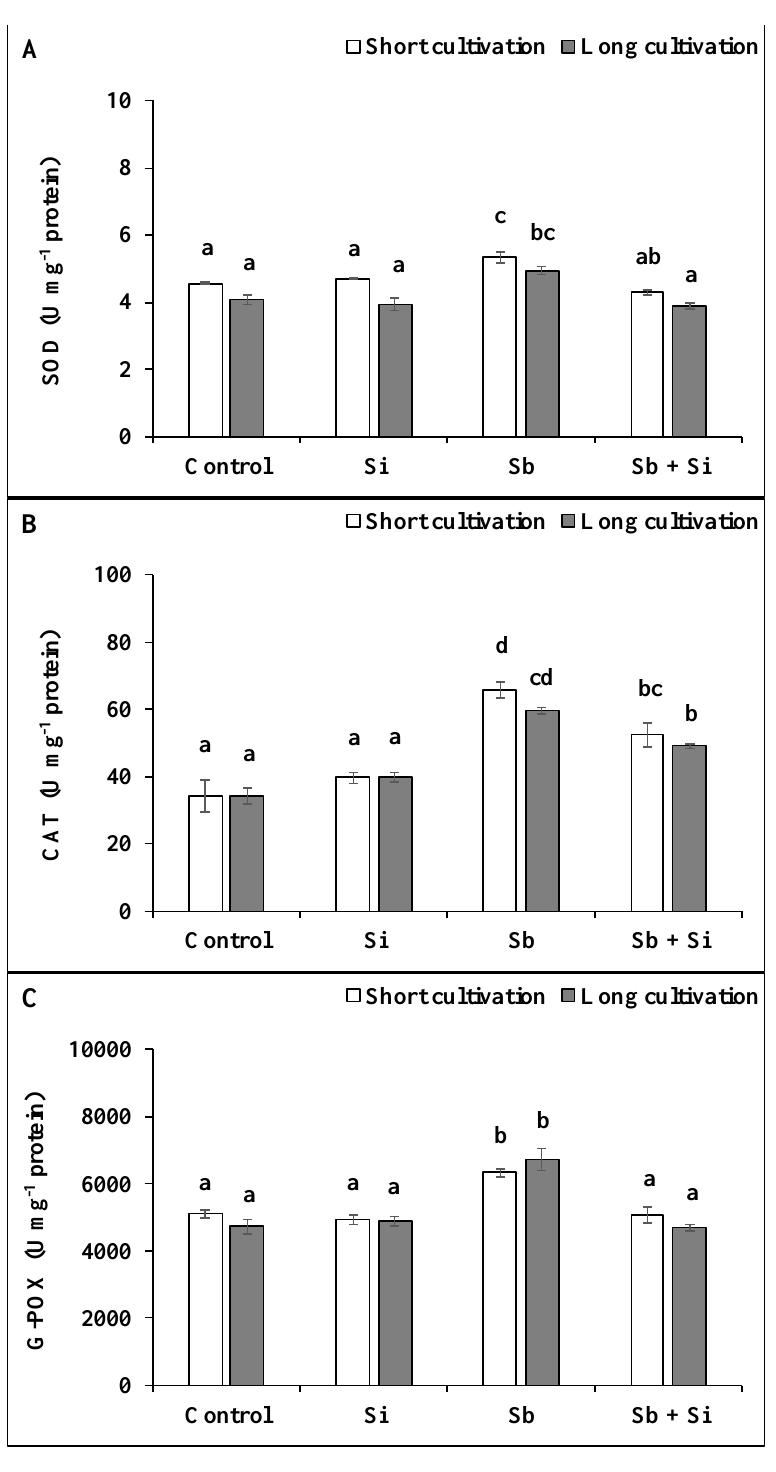
Figure 6. Activity of SOD (superoxide dismutase) ( A ), CAT (catalase) ( B ), G-POX (guaiacol peroxidase) ( C ) in the poplar calli after the short and long cultivations. The data are presented as the means ± standard error ( n = 6). Control—basal medium; Si treatment—basal medium + Si (5 mM); Sb treatment—basal medium + Sb (0.2 mM); Sb + Si treatment—basal medium + Sb (0.2 mM) and Si (5 mM). Different letters above bars denote statistically significant differences in the parameters between the treatments at p < 0.05 according to the Tukey test.